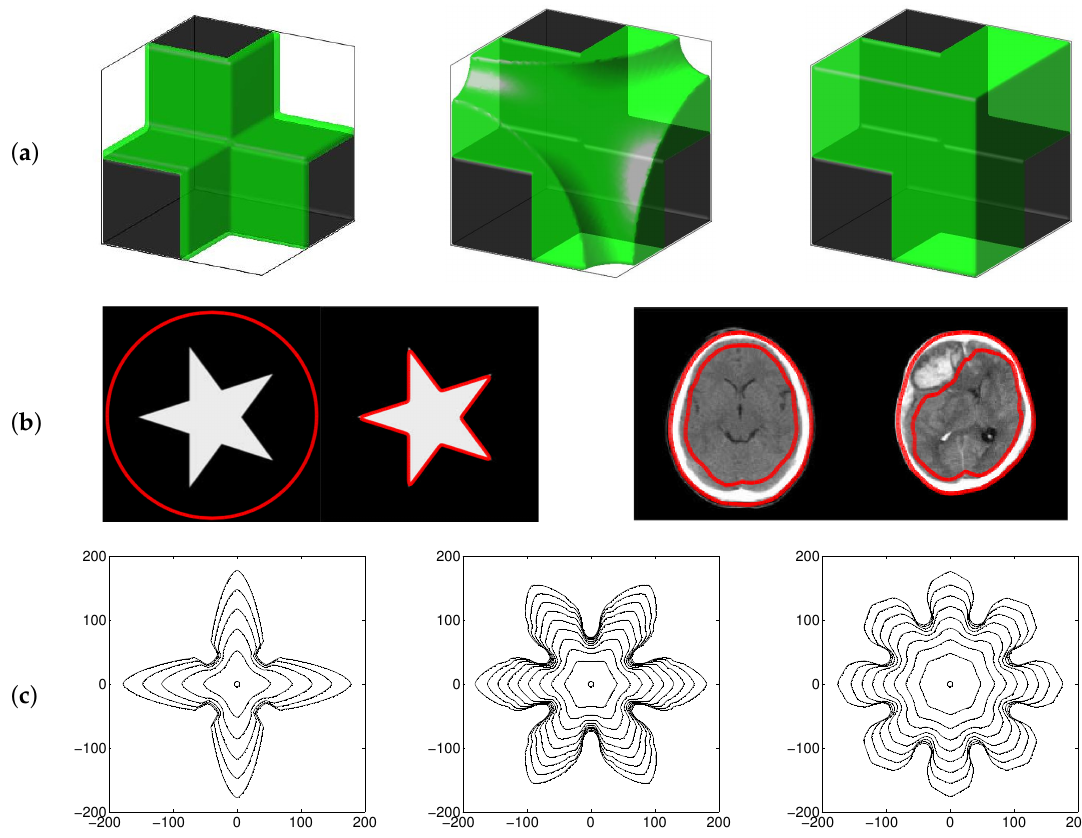
Figure 4. ( a ) Tissue growth on bioscaffolds. Reprinted from [5] with permission from MDPI. ( b ) Image segmentation. Reprinted from [6] with permission from Hindawi. ( c ) Crystal growth. Reprinted from [7] with permission from